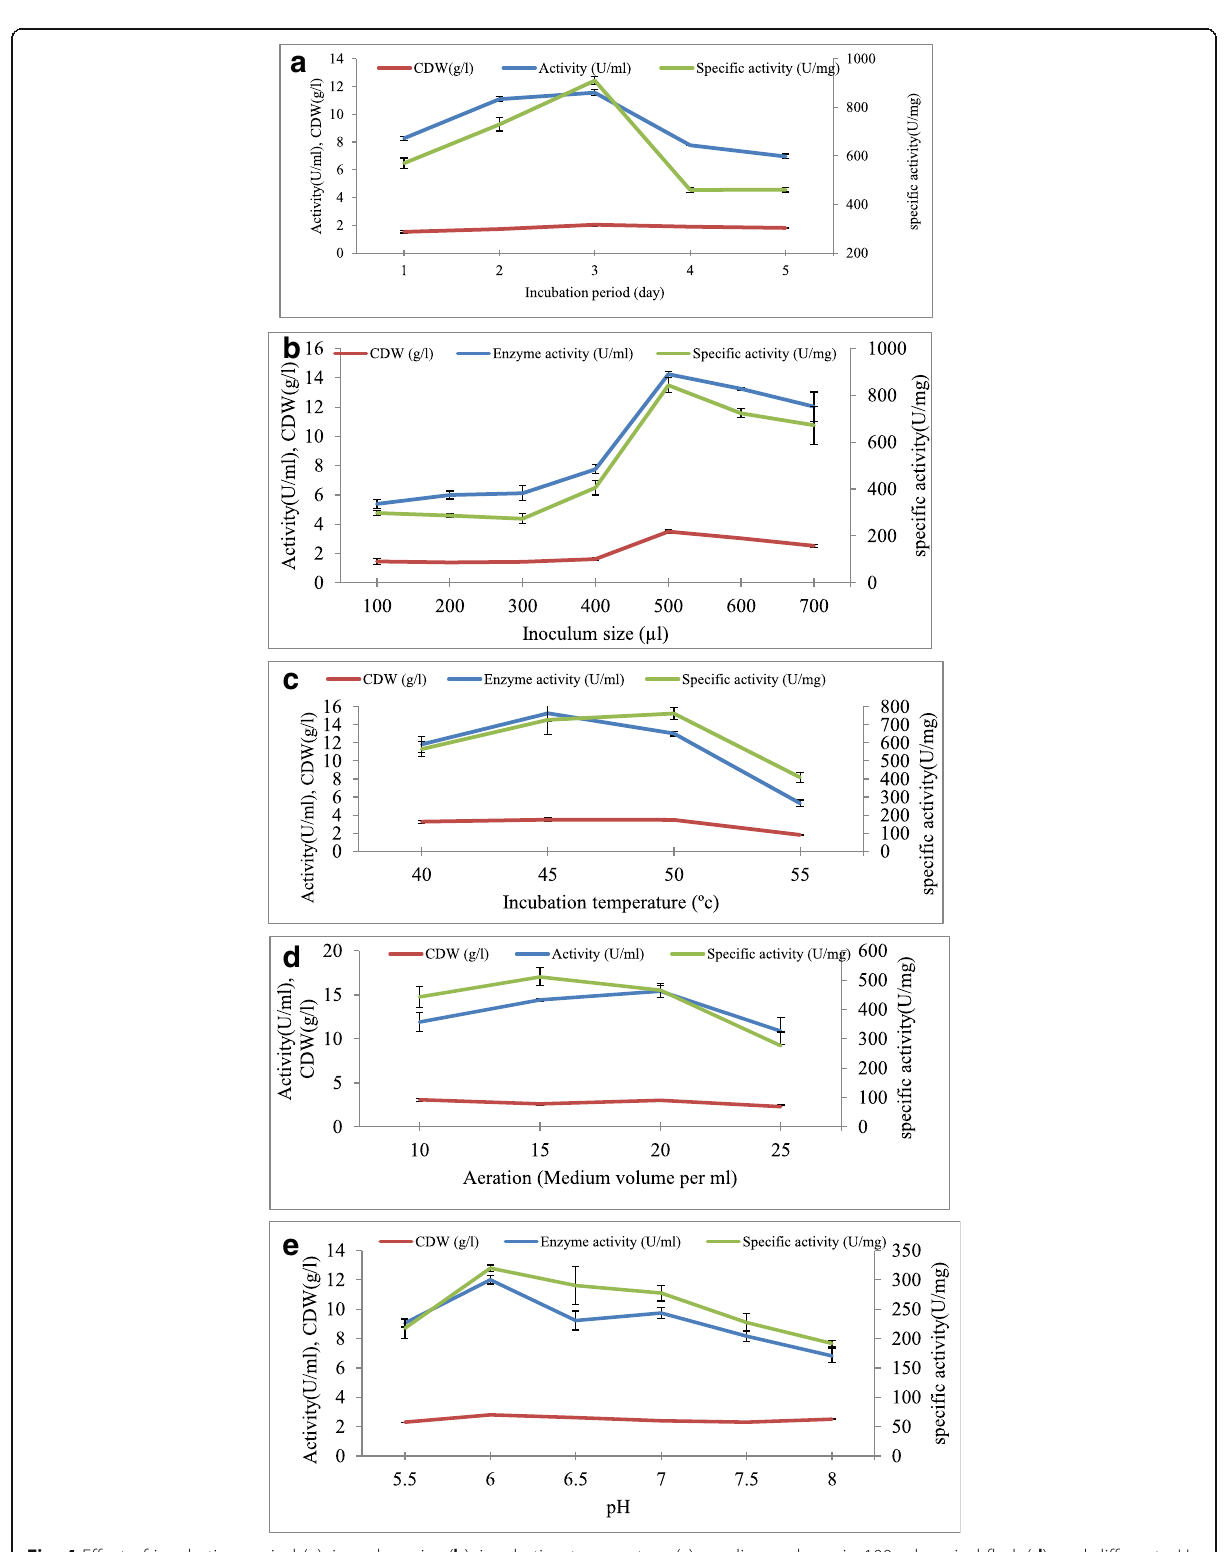
Fig. 4 Effect of incubation period ( a ), inoculum size ( b ), incubation temperature ( c ), medium volume in 100 ml conical flask ( d ), and different pH values ( e ) on α -amylase production by Bacillus sp. NRC22017. Data were expressed as mean ± standard